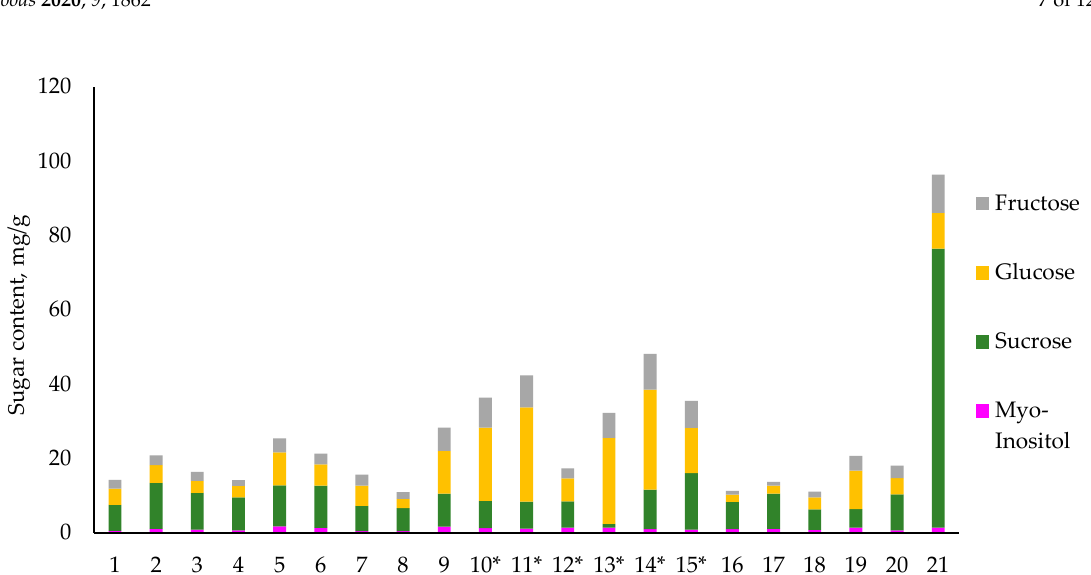
Figure 3. The total content of sugars from analyzed potato tubers Samples 1–18 correspond to purple-fleshed tubers, samples 19–20 to yellow-fleshed tubers and sample 21 to a purple sweet potato tuber. * p < 0.05 for total sugars between cross-breeds of Blue Congo with Granola compared to all other potato tubers.